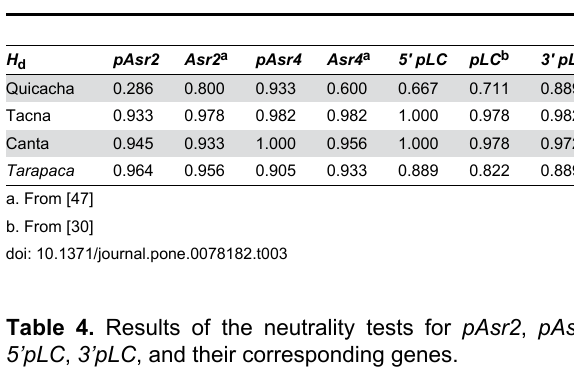
Table 3. Haplotype diversity of pAsr2 , pAsr4 , 5’pLC , 3’pLC , and their corresponding genes.